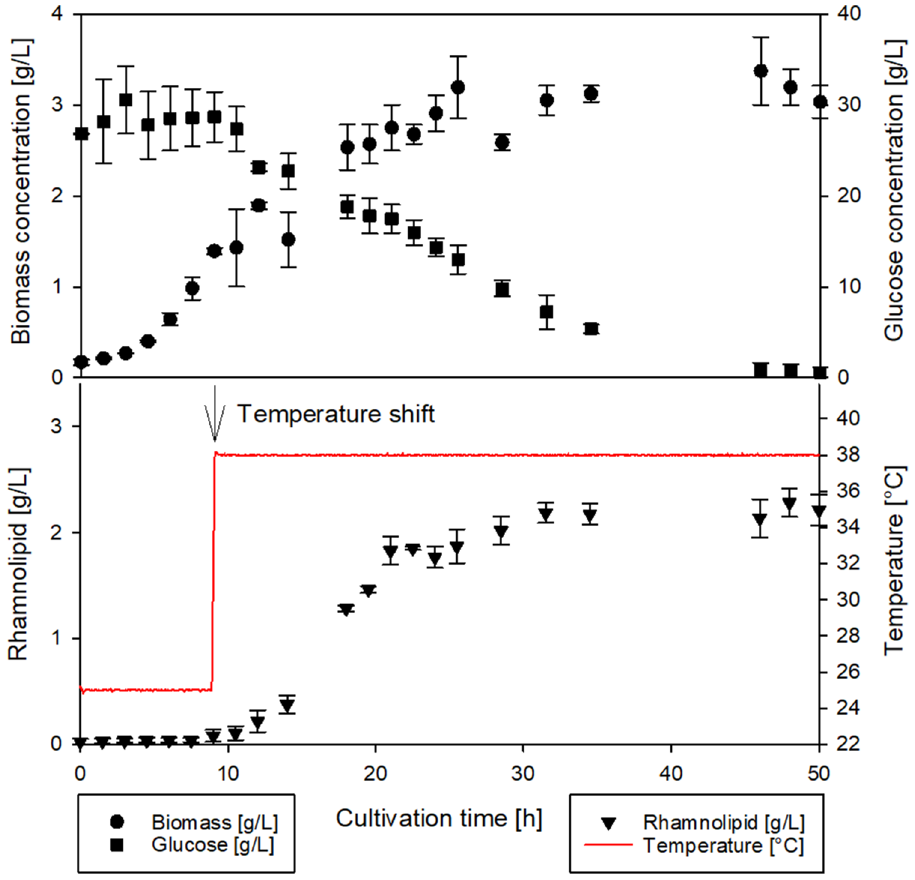
Figure 5. Bioreactor batch cultivation of Pseudomonas putida KT2440 pSynPro8oT_4U_ rhlAB in ModR medium with 30 g/L glucose. Time courses of measured biomass- (circles), and glucose concentration (squares) are shown in the upper plot as well as rhamnolipid concentration (triangles) and measured temperature (red line) in the bottom plot. Biomass was grown at 25 °C until reaching an OD 600 of 4 (approx. 1.4 g/L, after ~ 9 h). Then temperature was switched to 38 °C to induce rhamnolipid production as indicated by an arrow at the bottom